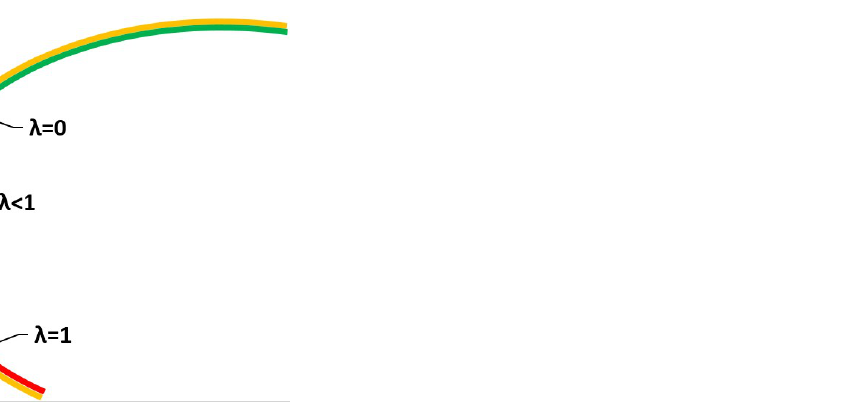
Figure 6. Solutions using WGP separately for expected values and standard deviations,under the satisficing philosophy plus straight